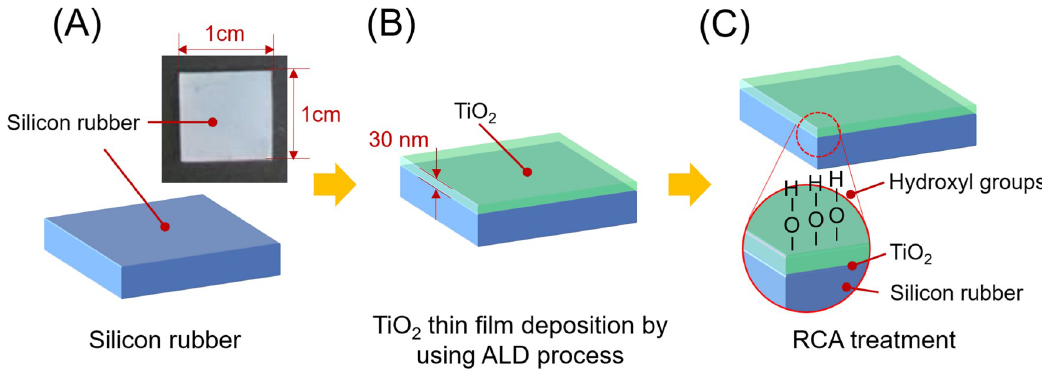
Fig 1. Creation of drug-coated implants. (A) An adequately sized silicone plate was prepared. (B) After titanium dioxide was hydrophilic coated up to a 30-nm thickness on the surface of the silicone plate using atomic layer deposition, the silicone plate could be coated with the candidate drugs using the nanometer scale. (C) RCA treatment, i.e., washing with hydrogen peroxide and ammonia aqueous solution, was performed before target drug treatment to eliminate cations present in the air and to retain the OH radical. The silicone plate was effectively coated with the target drugs. ALD = atomic layer deposition, RCA = Radio Corporation of America.